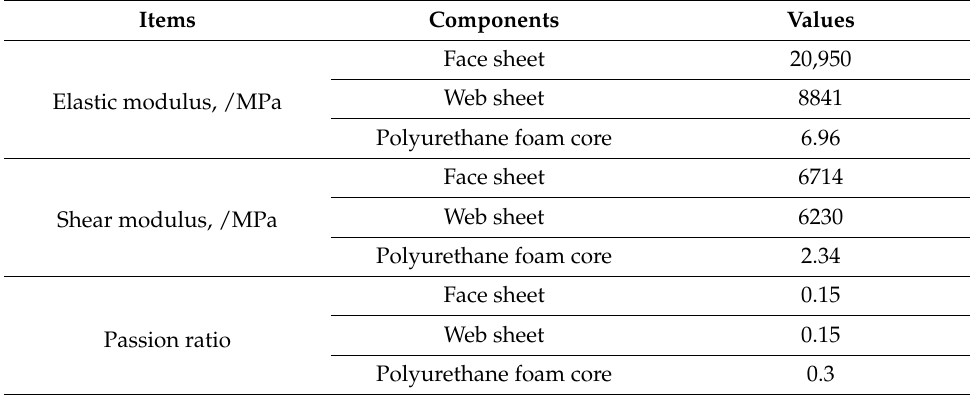
Table 5. Material